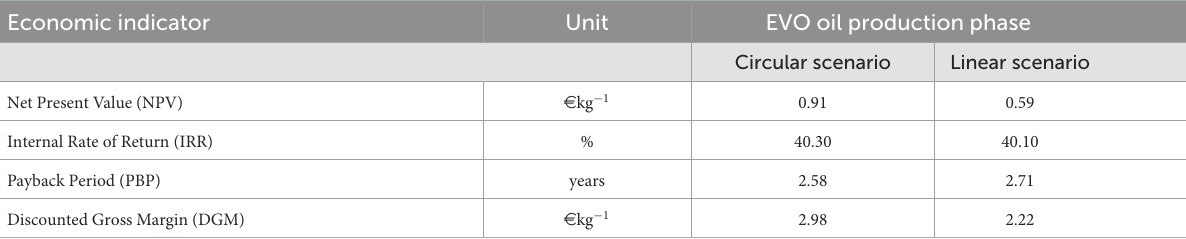
TABLE 6 Investment analysis of the circular vs . linear